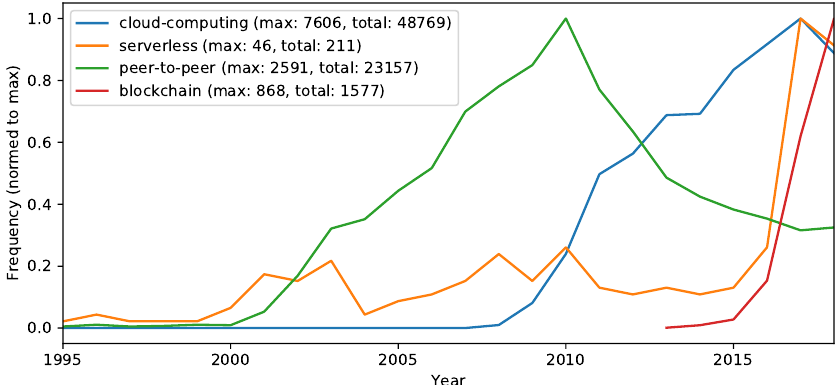
Figure 10. Trends of papers dealing with the terms cloud-computing, serverless, P2P, and blockchain (as the latest P2P based trend). Retrieved from Scopus (limited to computer science), 2018